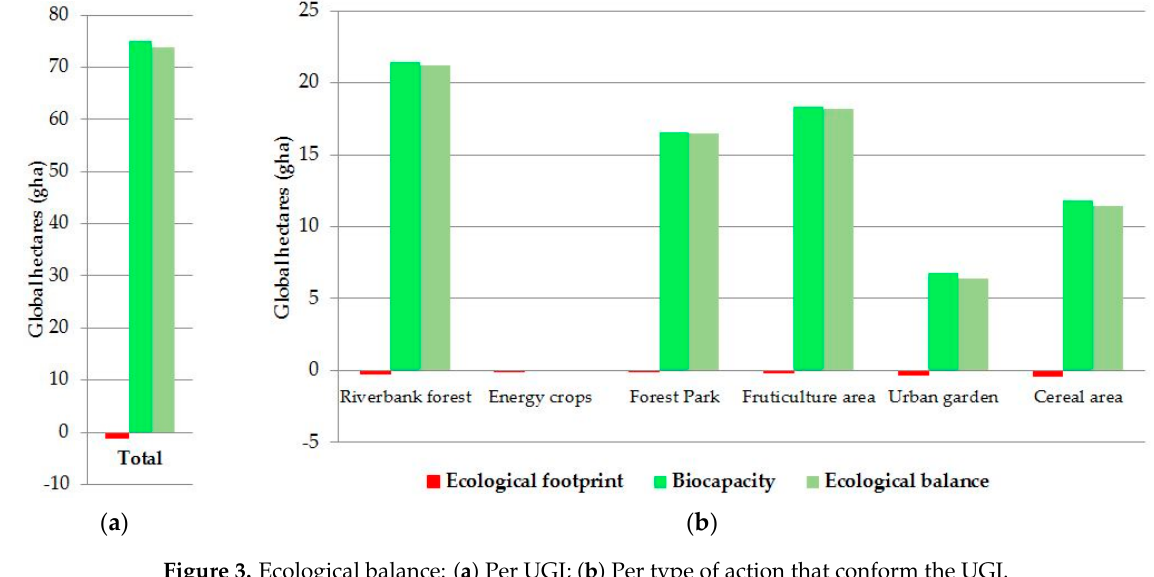
Figure 3. Ecological balance: ( a ) Per UGI; ( b ) Per type of action that conform the UGI.